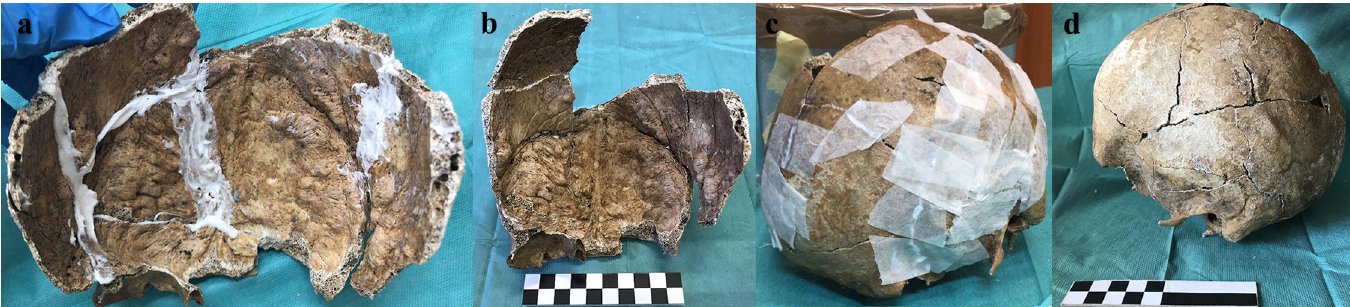
PLOS ONE | https://doi.org/10.1371/journal.pone.0281727 March 6,